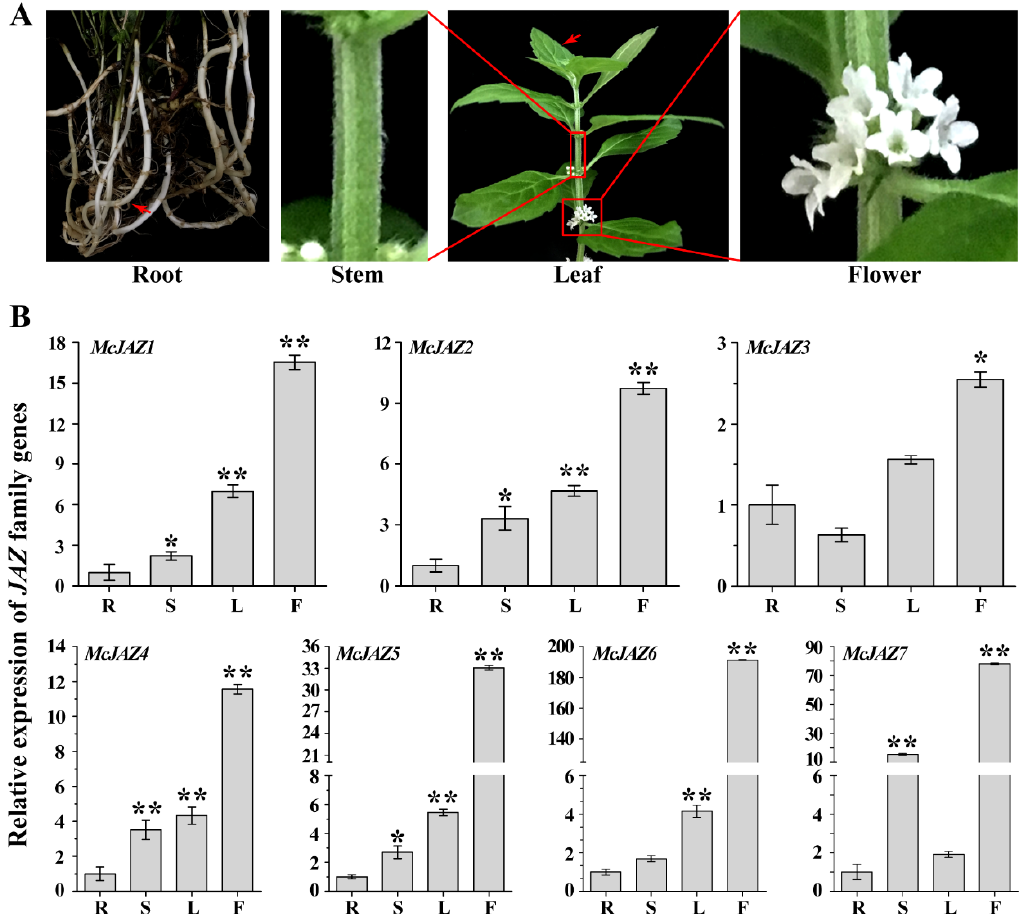
Figure 4. Tissue-specific expression patterns of M. canadensis McJAZ genes. ( A ) The different tissues used for total RNA extraction, including Root (R), Stem (S), Young Leaf (L) and Flower (F). The red arrow indicates the position at which root and leaf tissues were collected. ( B ) Quantitative real-time (qRT)-PCR analysis of each McJAZ gene expression in the indicated M. canadensis tissues. The expression level of each McJAZ gene was normalized to β -actin gene and relative expression values are compared in root. Data are presented as means ± SE of three independent replicates, and significant differences between the expression level of each McJAZ gene in root tissue versus other tissue was analyzed by Student’s t -test (* p < 0.05 or ** p < 0.01).